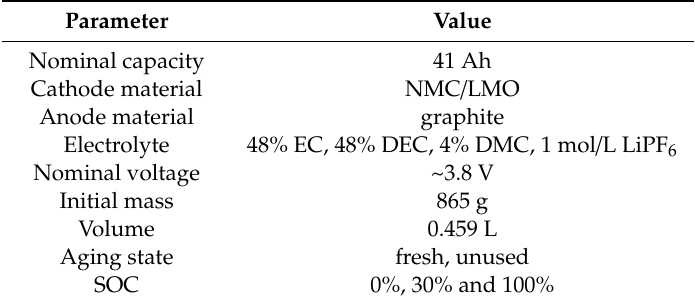
Table 1. Specification of the automotive Li-ion pouch